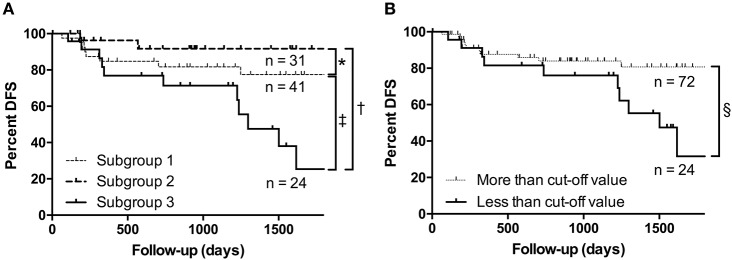
Kaplan–Meier analyses. (A) The rate of metachronous metastasis according to the miRNA expression subgroup. (B) Association between the presence of metachronous metastasis and the expression level of miRNA-135a-5p. *P < 0.471; †P < 0.003; ‡P < 0.018; §P < 0.016.